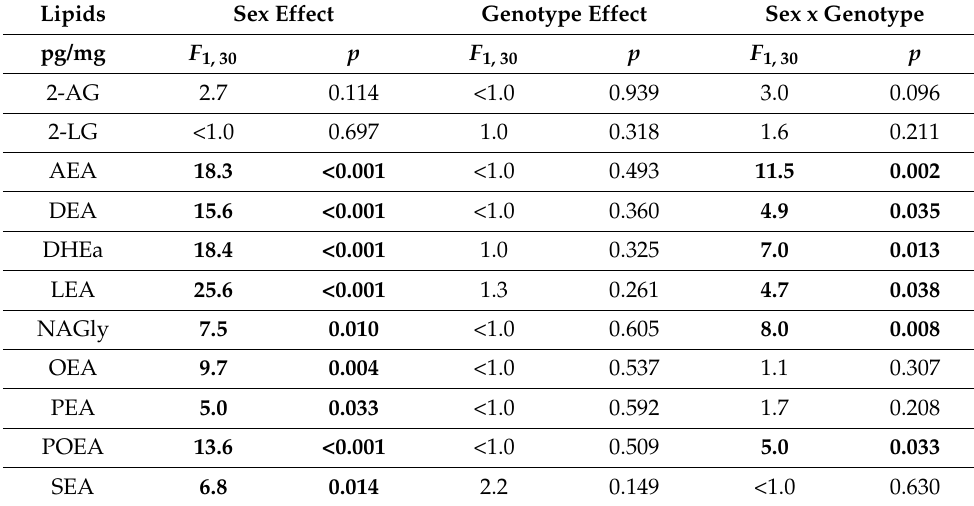
Table 1. ANOVA results for sex and genotype on eCB and other lipid signaling molecule levels (pg/mg) in the prefrontal cortex of HIV Tat transgenic mice a .